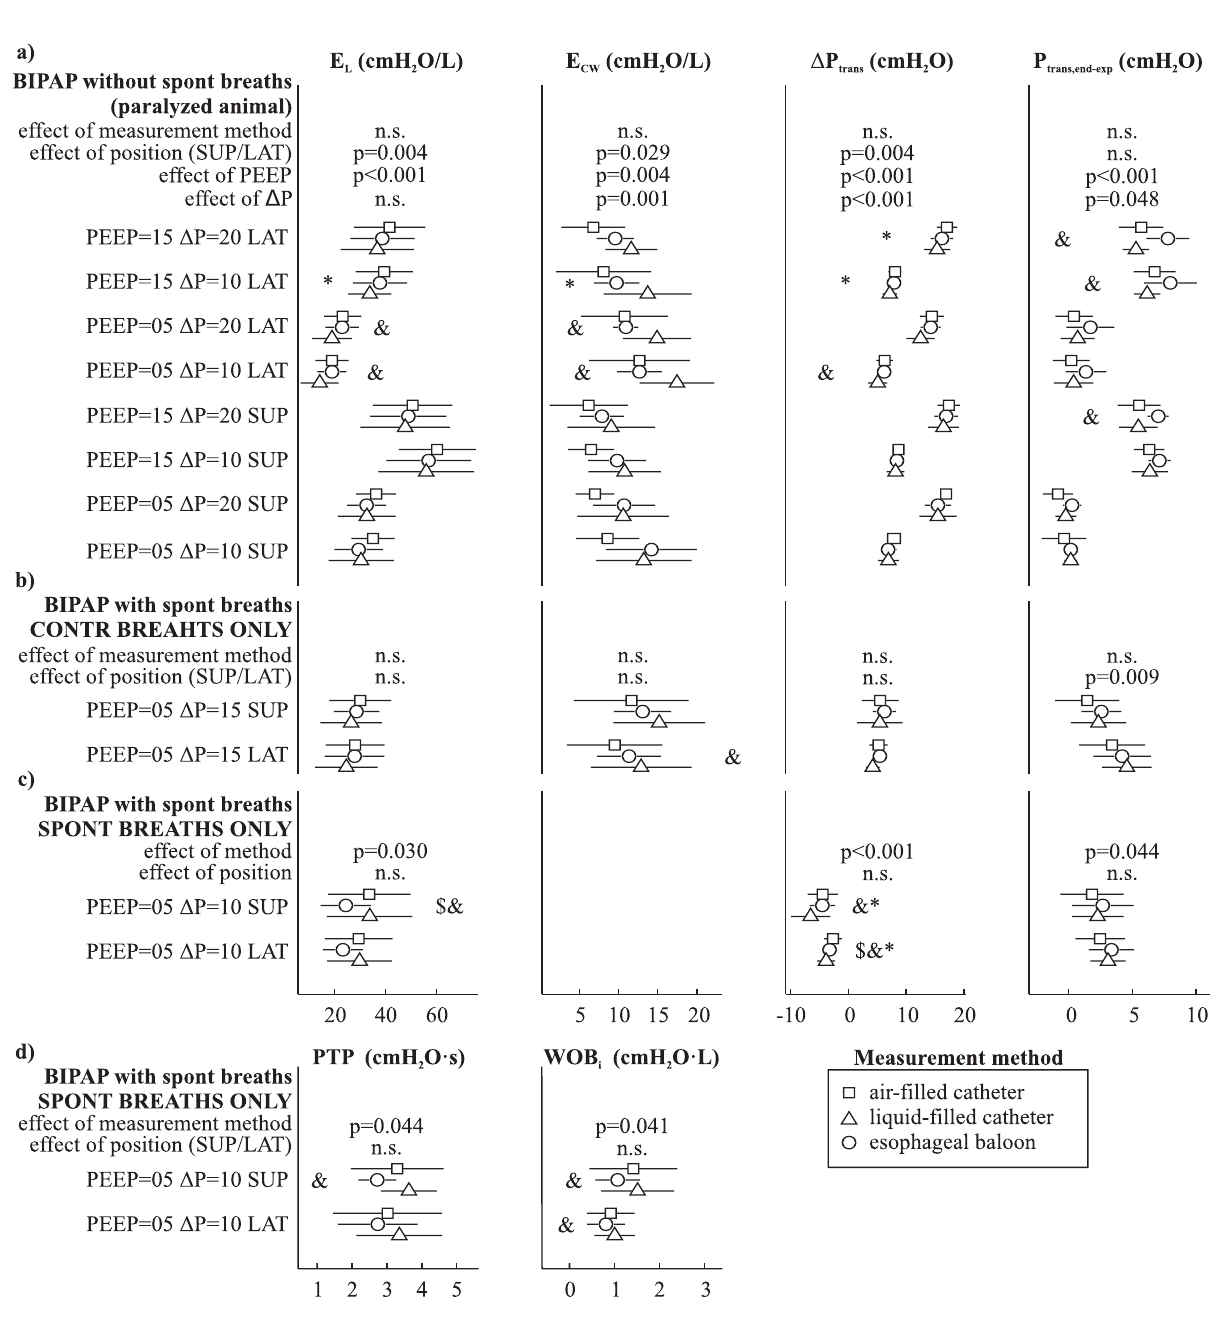
Figure 4. Average value ( ± SD) of the parameters derived from esophageal pressure measurements under different settings of BIPAP (biphasic positive airway pressure) mechanical ventilation: a) controlled ventilation (with animal paralyzed using atracurium bromide); b) assisted ventilation (allowing unsupported spontaneous breaths), considering only the controlled breaths; c) and d) assisted ventilation, considering only the unsupported spontaneous breaths. PEEP: positive end-expiratory pressure (cmH 2 O); D P: